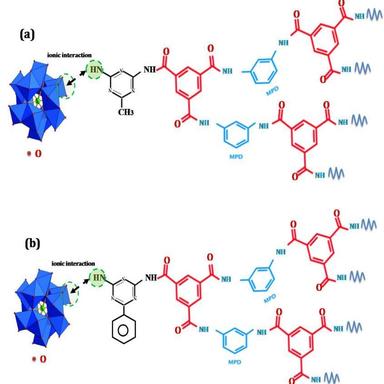
The proposed reactions of interfacial polymerization with PA active layer (a) PMAA, and (b) PMAB hybrid materials.